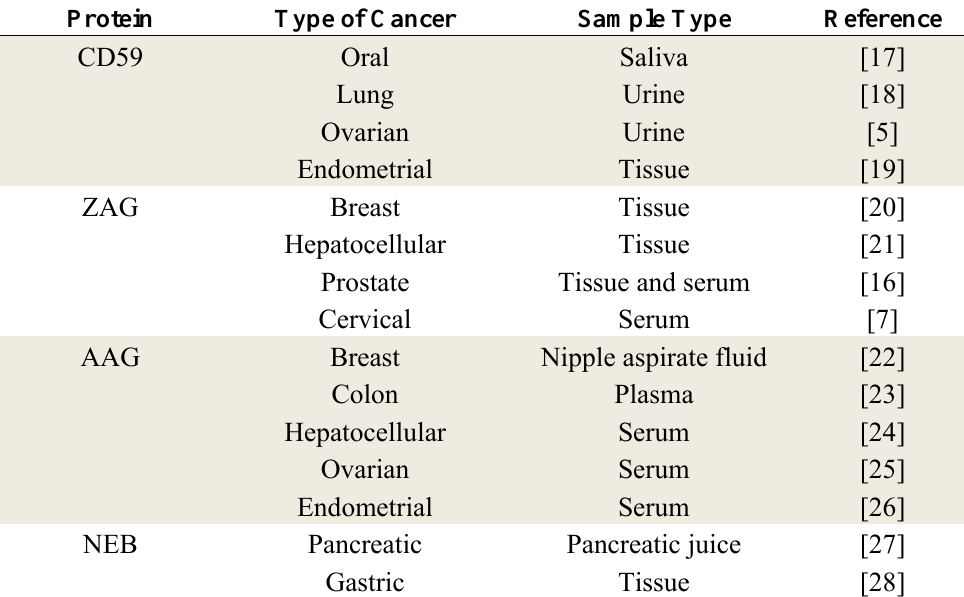
Table 5. Identification of CD59, ZAG, AAG and NEB as potential biomarkers. Check this